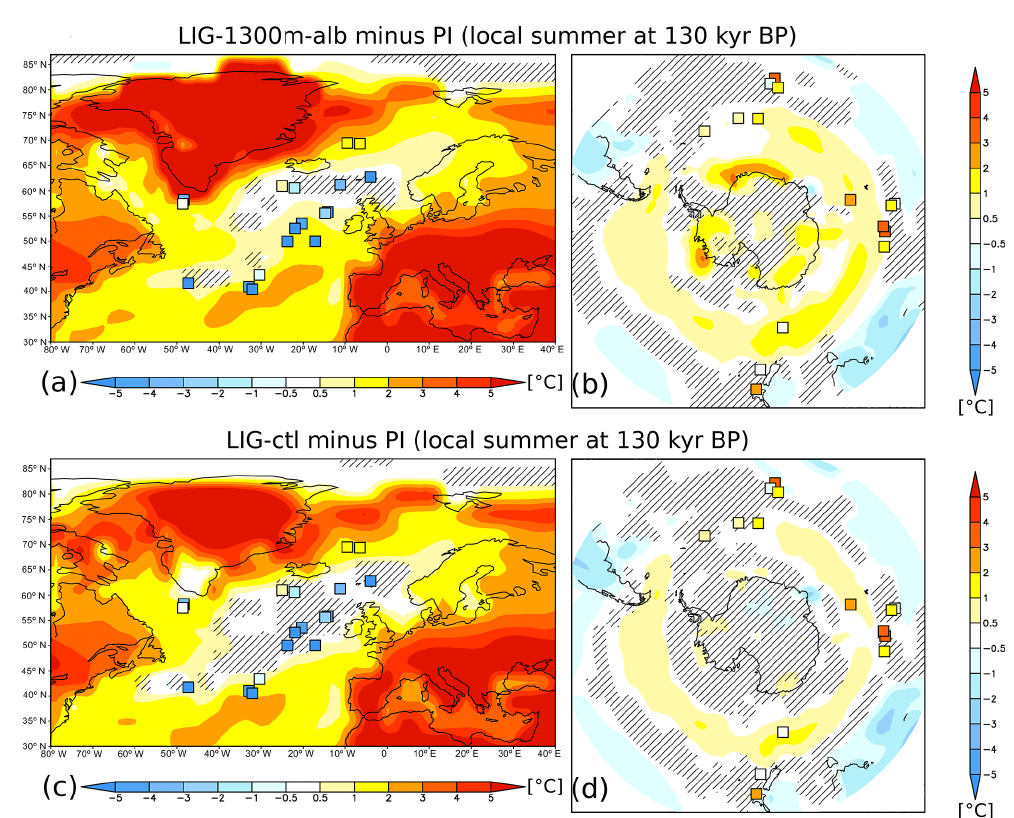
Figure 10. Effect of (a, b) Greenland Ice Sheet elevation, insolation, albedo, and atmospheric methane concentration and (c, d) insolation and atmospheric methane concentration at 130kyrBP relative to pre-industrial (PI). Model–data comparison of mean local summer temperature anomalies. The shading represents the simulated surface temperature (TS) anomalies derived from (a, b) LIG-1300m-alb and (c, d) LIG-ctl. Hatched areas mark statistically insignificant TS anomalies. The squares show marine proxy-based LIG (130kyrBP) summer temperature anomalies relative to present day derived by Capron et al.